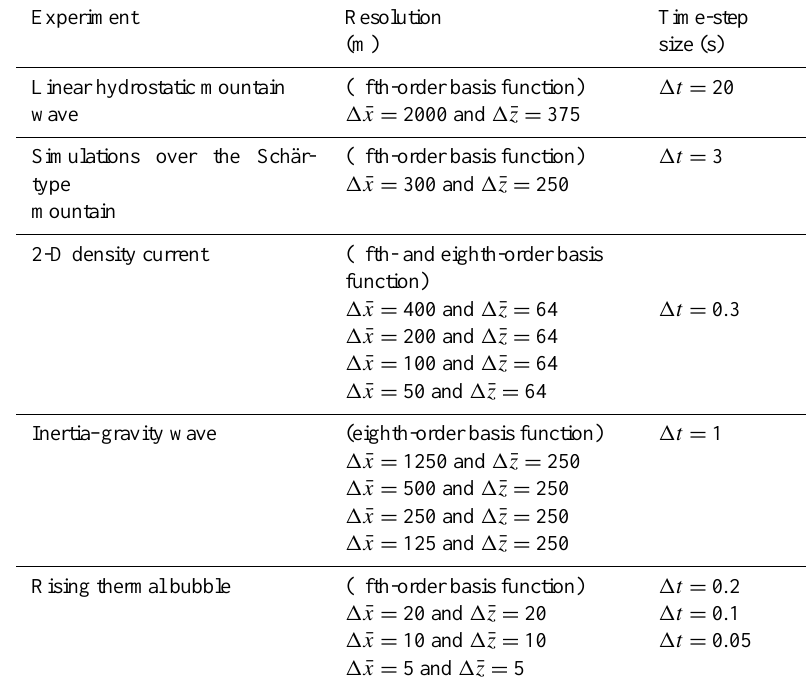
Table 1. Summary of the resolutions and time-step sizes used for the tests. Experiment Resolution (m) Linear hydrostatic